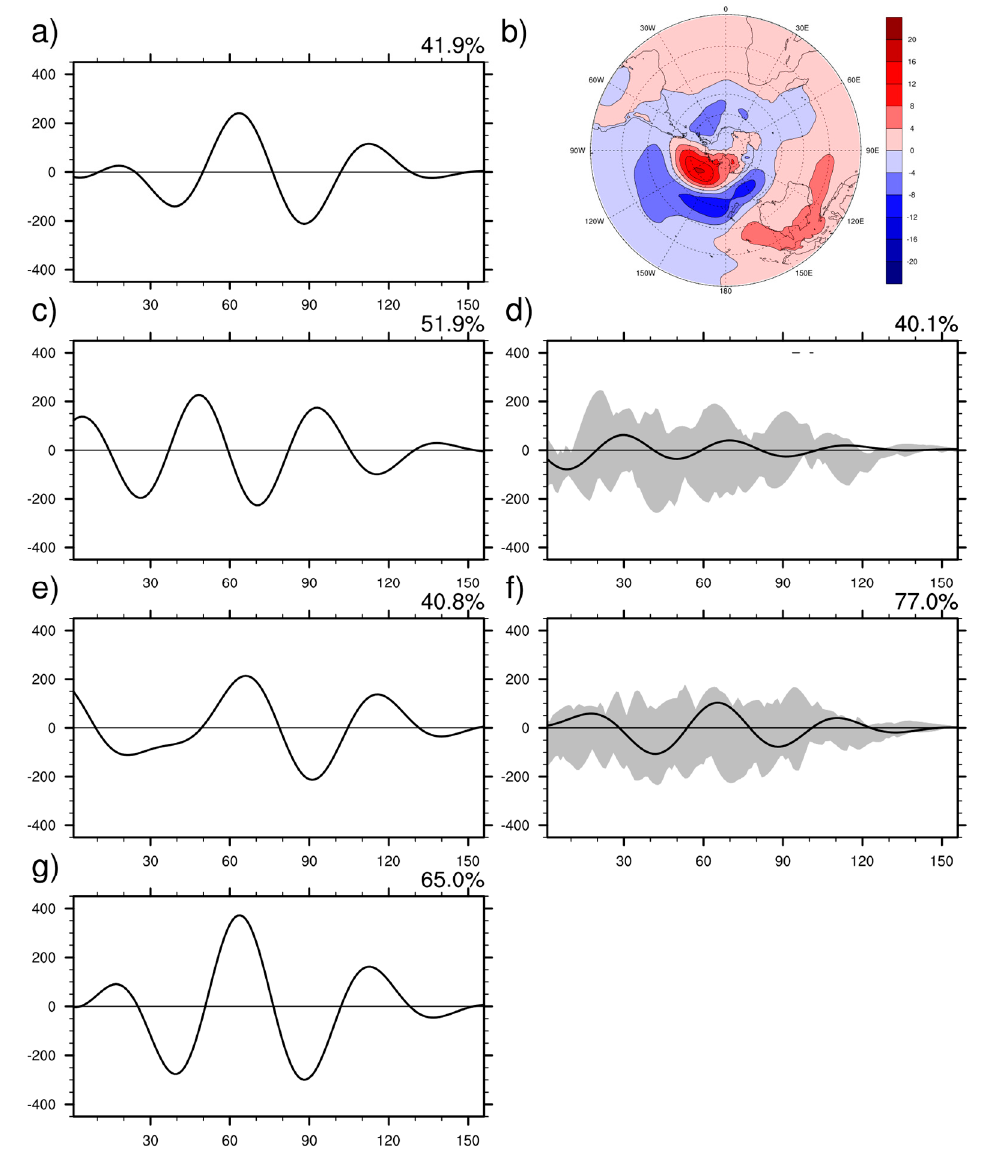
Figure 4. Time series and spatial pattern for the first empirical orthogonal function (EOF) mode of SLP from the ERA5 dataset ( a , b ) and selected models ( c – g ), with the explained percentage of variance given on the top right (5–95% percentile shaded). Models ( c – g ) are the same as Figure 3 ( b – f ).